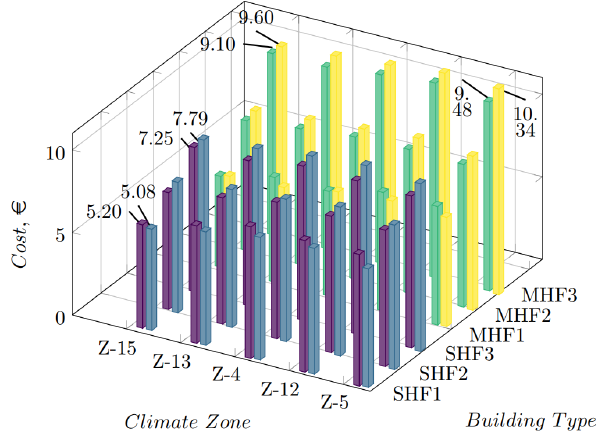
Figure 15. Cost comparison between full-load (left column, purple and green) and partial-load operation (right column, blue and yellow) for different climate zones and building types, for a WSB typical day (winter, weekend day, cloudy).